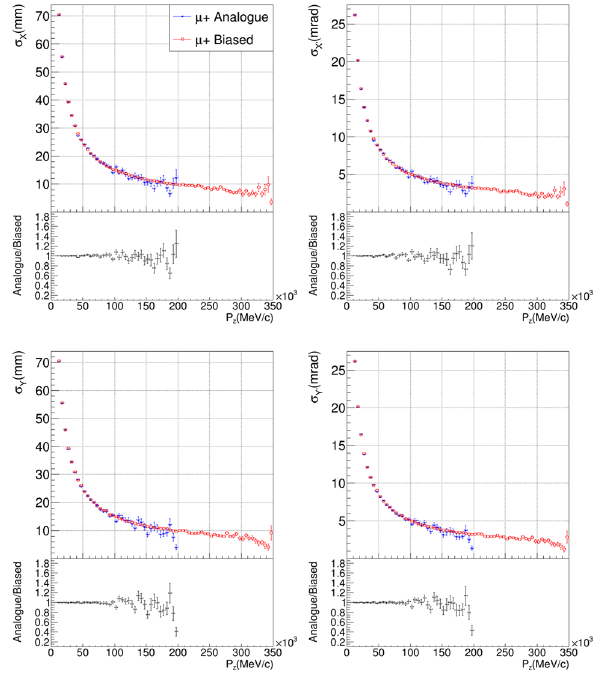
Fig. 4 Standard deviation of the μ + position x , y (left panels) and muon direction angle x (cid:4) , y (cid:4) (right panels) at the downstream face of the absorber as a function of the μ + momentum. Distributions for x and x (cid:4) ( y and y (cid:4) ) are shown in the top (bottom) panels. The analogue (biased) distribution is shown by the blue filled (red open) dots. The ratios between the analogue and biased distributions are also shown